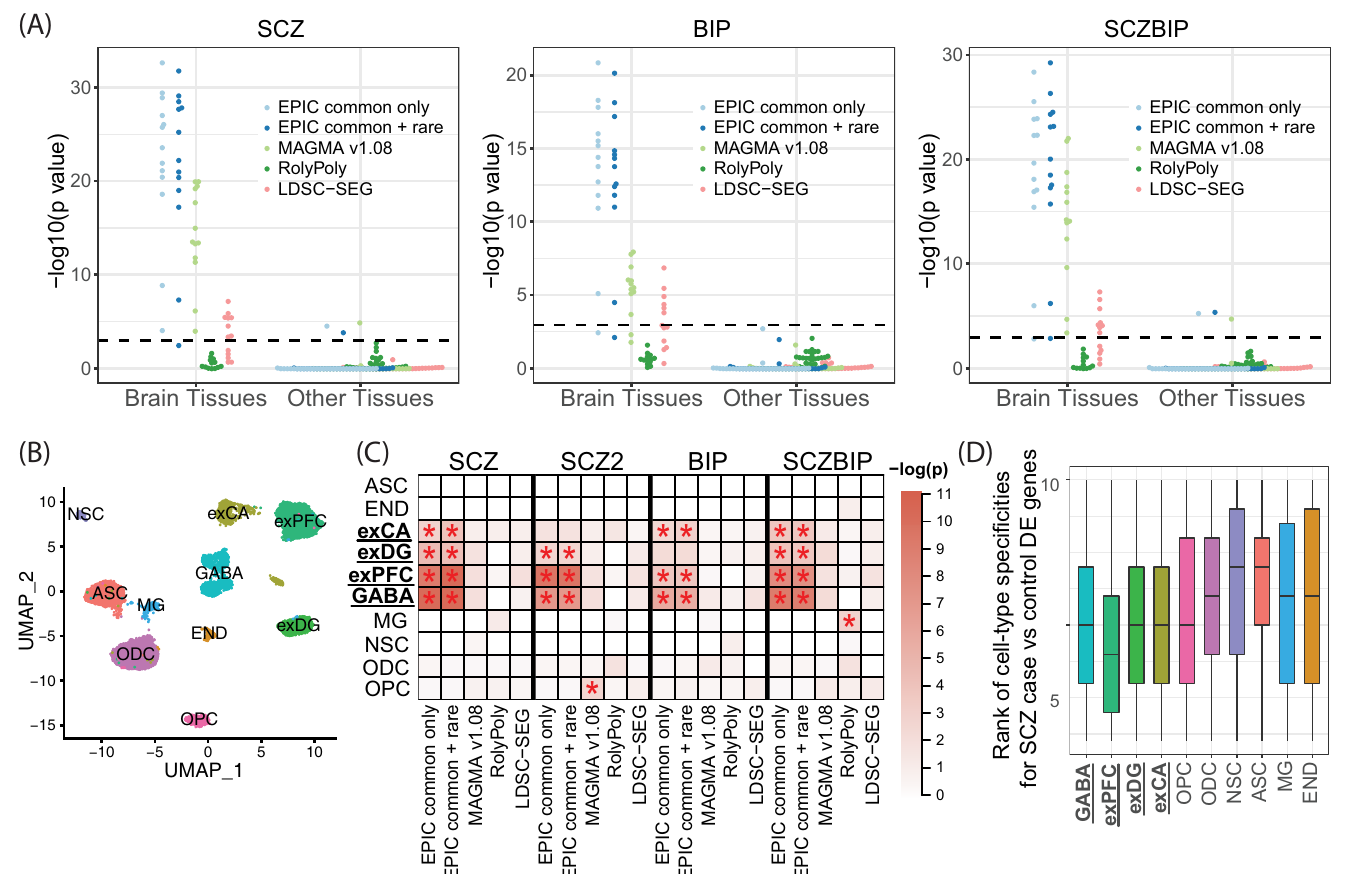
Fig 4. Cell-type-specific enrichment for three neuropsychiatric disorders. (A) Beeswarm plot of–log10( p -value) from the tissue enrichment analysis using GTEx bulk RNA-seq data. The dashed line is Bonferroni corrected p -value threshold. (B) UMAP embedding of 14,137 single cells from five donors. (C) Heatmap of–log10 ( p -value) from the cell-type enrichment analysis using GTEx scRNA-seq brain data. Bonferroni-significant results are marked with red asterisks. GABA: GABAergic interneurons; exPFC: excitatory glutamatergic neurons in the prefrontal cortex; exDG: excitatory granule neurons from the hippocampal dentate gyrus region; exCA: excitatory pyramidal neurons in the hippocampal Cornu Ammonis region; OPC: oligodendrocyte precursor cells; ODC: oligodendrocytes; NSC: neuronal stem cells; ASC: astrocytes; MG: microglia cells; END: endothelial cells. (D) Boxplot of gene-specificity ranks across ten brain cell types for differentially expressed genes from SCZ case-control